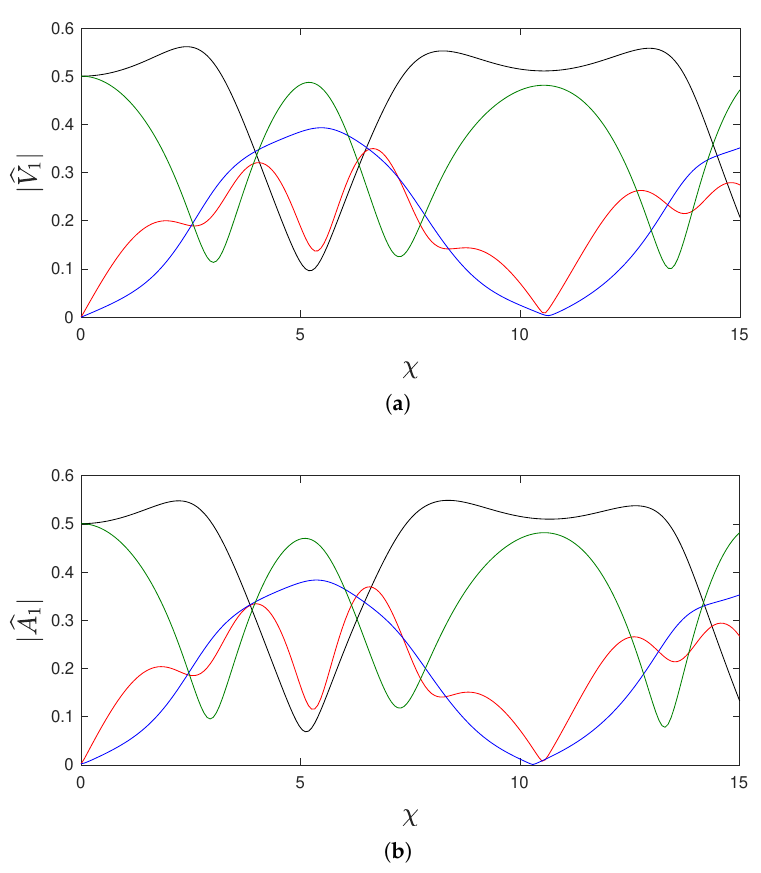
Figure 3. Computed sideband amplitudes of the first harmonic over a longer χ -interval for the same parameter values and same color notations as in Figure 2. The panels correspond to ( a ) our model (32), ( b ) spatial form (36) of the classical Dysthe’s